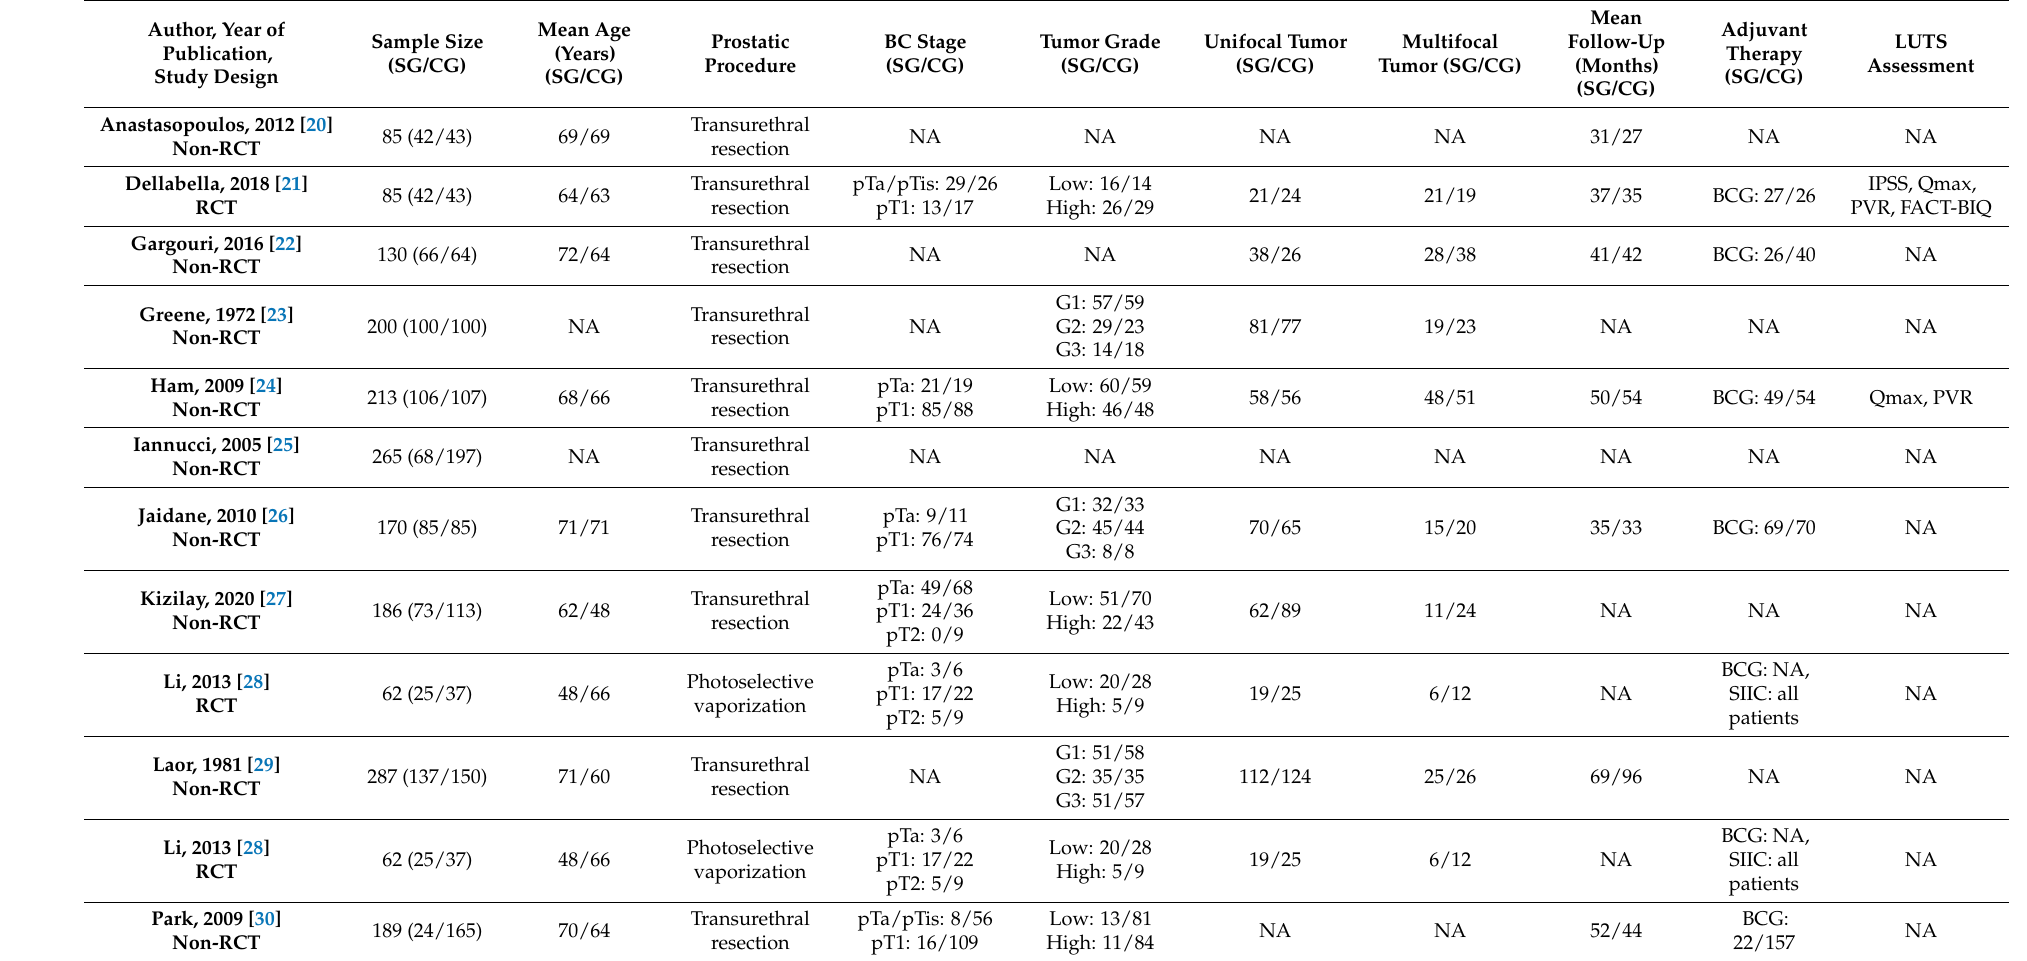
Table 1. Characteristics of all included